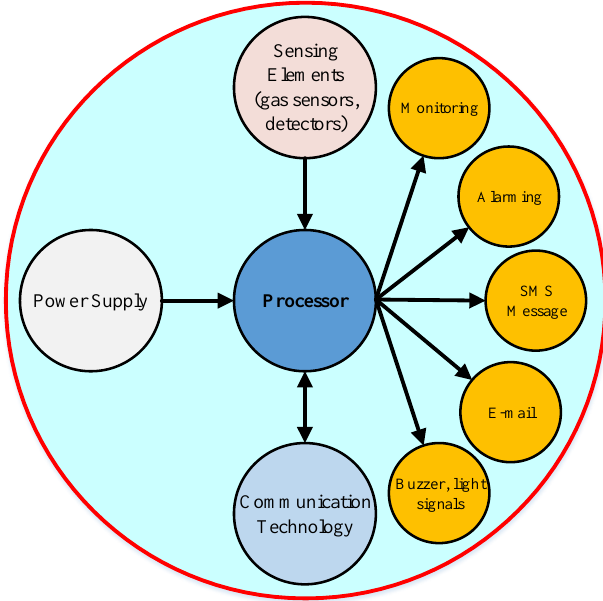
Figure 2. Basic block diagram of mobile detecting and alarming system.